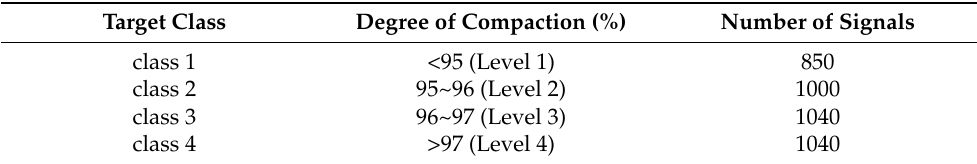
Table 4. Number of the collected signals for the validation test.